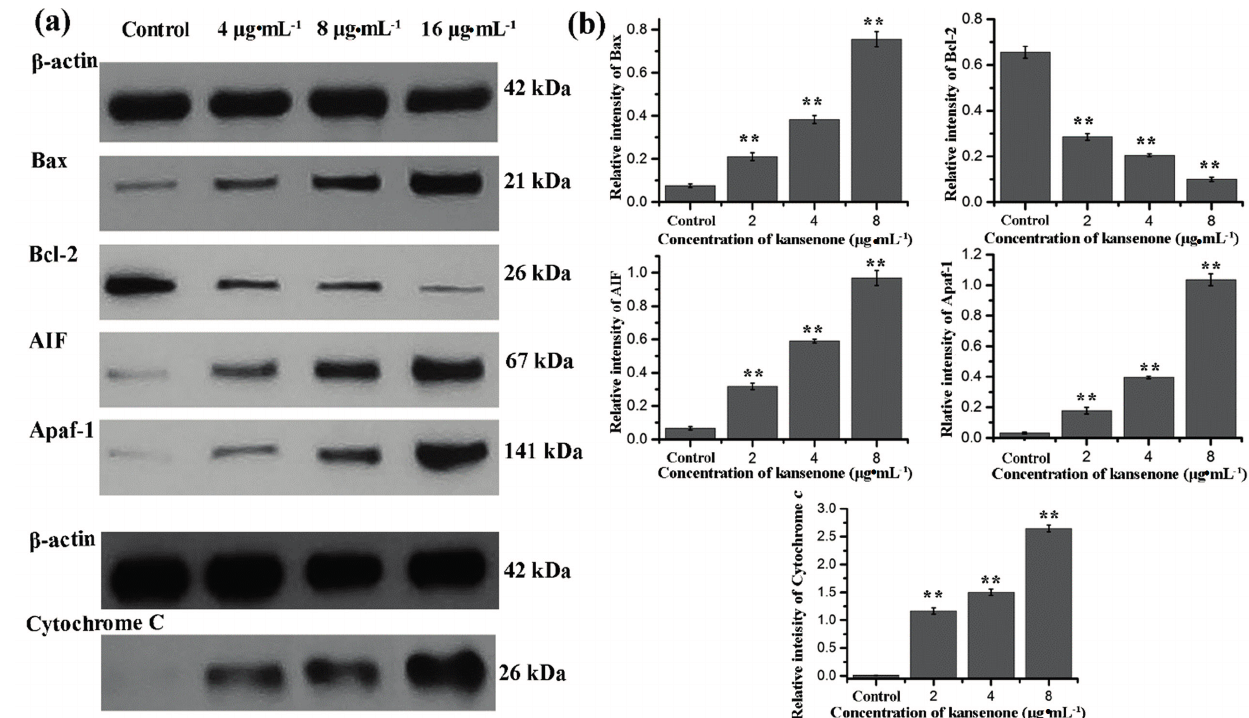
Figure 9. ( a ) Western blot analysis for Bax, Bcl-2, AIF, Apaf-1, and cytochrome c after treatment with kansenone for 48 h; ( b ) Relative intensity value of Bax, Bcl-2, AIF, Apaf-1, and cytochrome c . β -actin was used as an internal control. Compared with corresponding control group, ** p < 0.01.